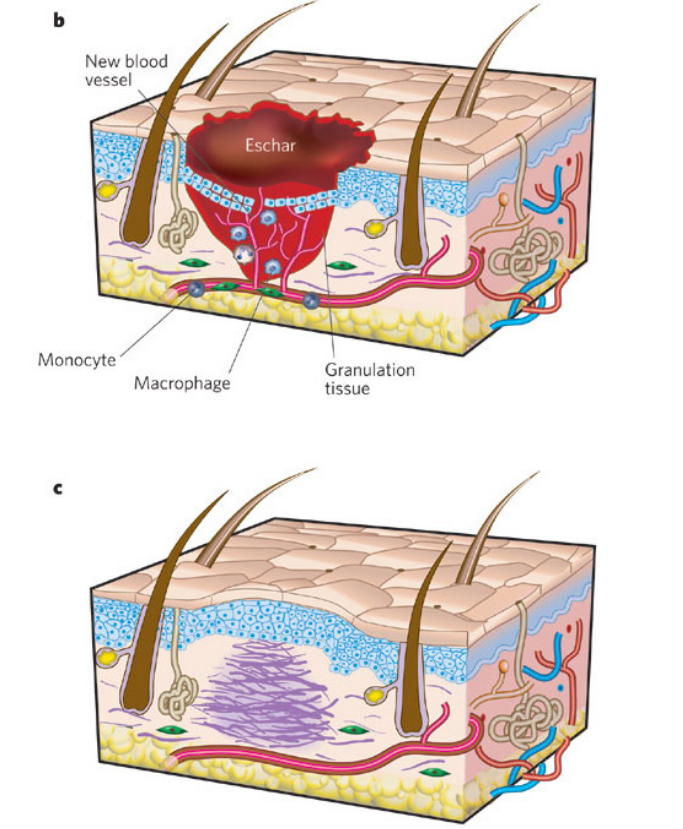
Figure 3. Wound healing stages: inflammation ( a ), proliferation ( b ) and tissue remodeling ( c ). ( a ) Inflammation is characterized by blood vessel injury, coagulation, and acute local inflammatory response with the formation of the protective clot against microbial infections; ( b ) The proliferation phase involves cell migration, granulation tissue formation, and angiogenesis; ( c ) Tissue remodeling implies the formation of a disorganized ECM as is depicted in the picture as well as a slightly elevated area together with the lack of normal skin appendages [22]. (Copyright Nature Publishing Group